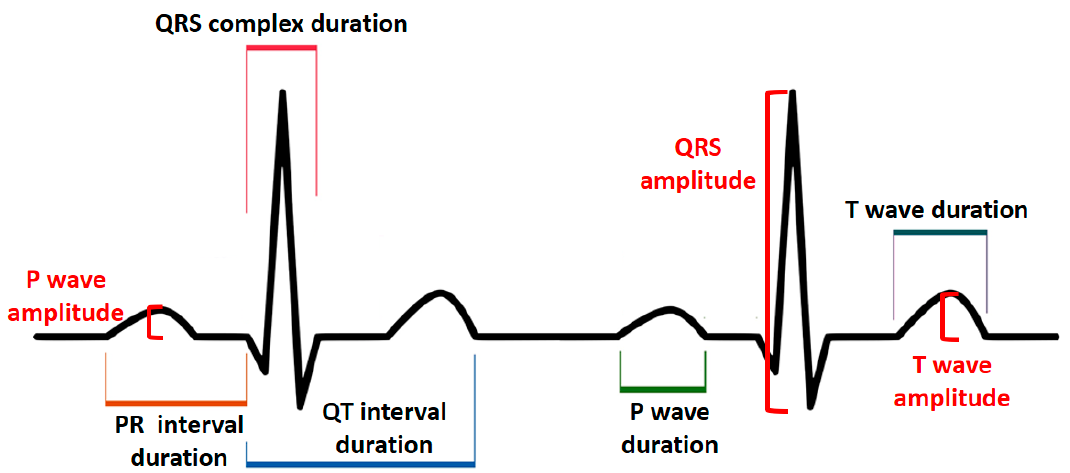
Figure 2. Principles of electrocardiogram assessment.